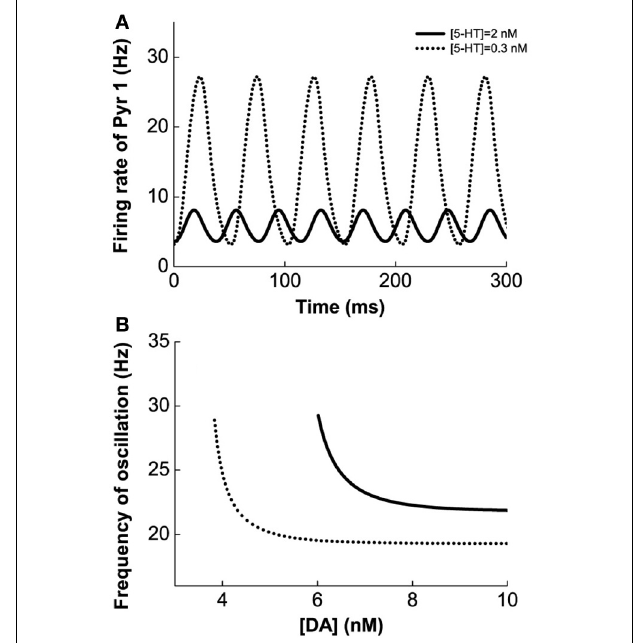
maximum (top) and minimum (bottom) firing rates during oscil- lation. The red lines represent collections of unstable steady states (or specifically, unstable fixed points), while the black lines repre- sent that for the asynchronous stable steady states (or stable fixed